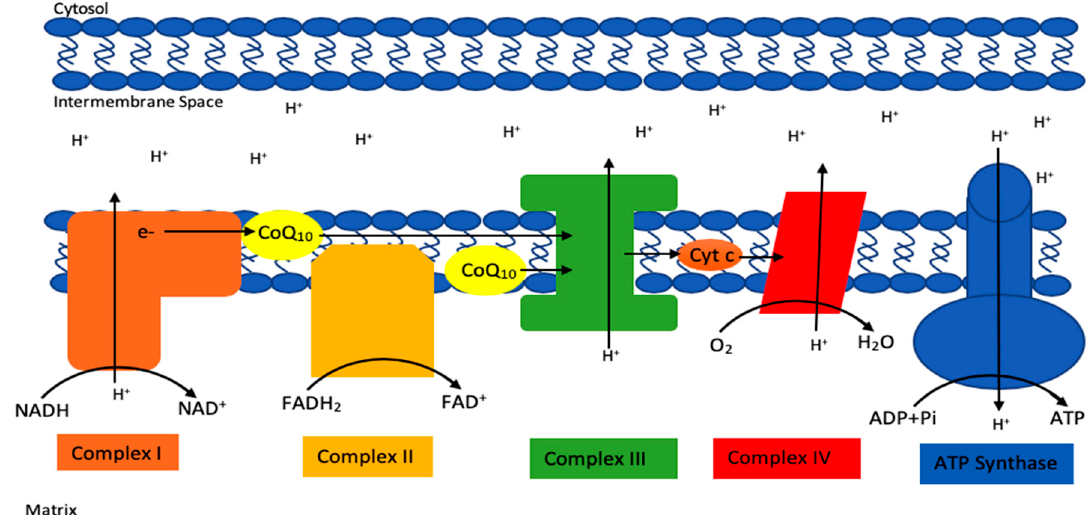
Figure 2. Basic schematic of the mitochondrial electron transport chain (METC), highlighting the electron carrier function of CoQ10 in the chain.